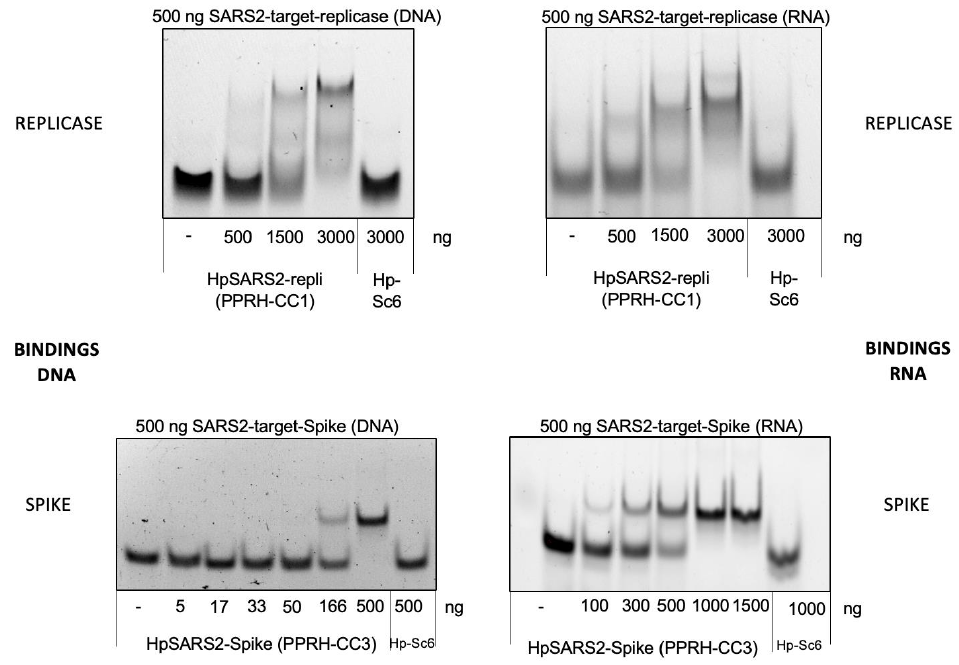
Figure 2. Binding of PPRHs CC1 and CC3 to DNA and RNA probes corresponding to SARS-CoV-2. Increasing amounts of PPRH-CC1 or PPRH-CC3 were incubated with 500 ng of 6-FAM-labeled ssDNA or ssRNA probes corresponding to replicase (top panel) or spike (bottom panel) sequences. Hp-Sc6 was included as a non-targeting control PPRH.